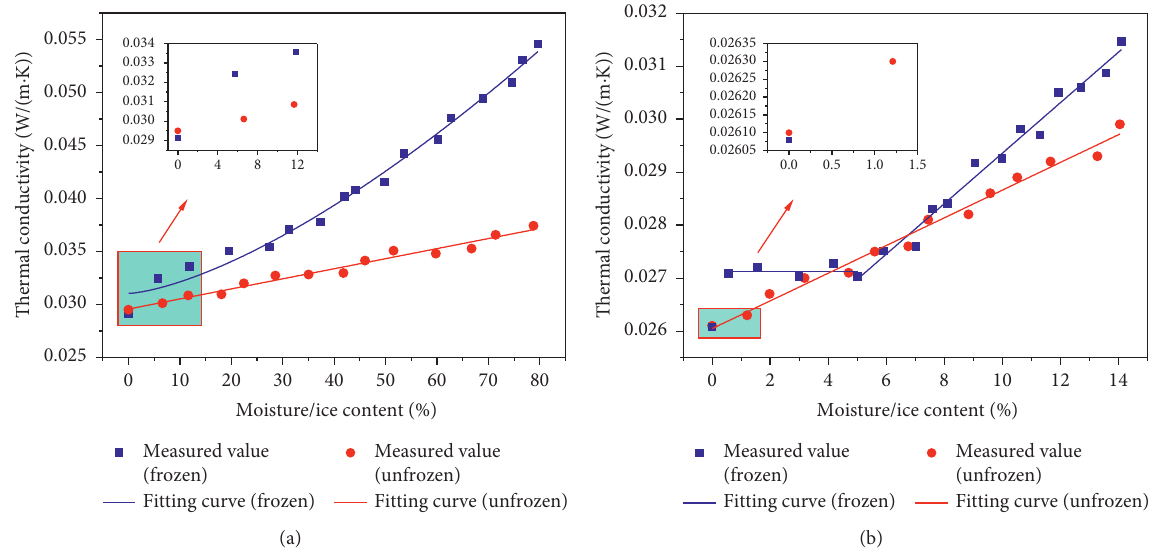
Figure 11: Thermal conductivity of the insulation material before and after freezing. (a) Polyphenolic. (b)